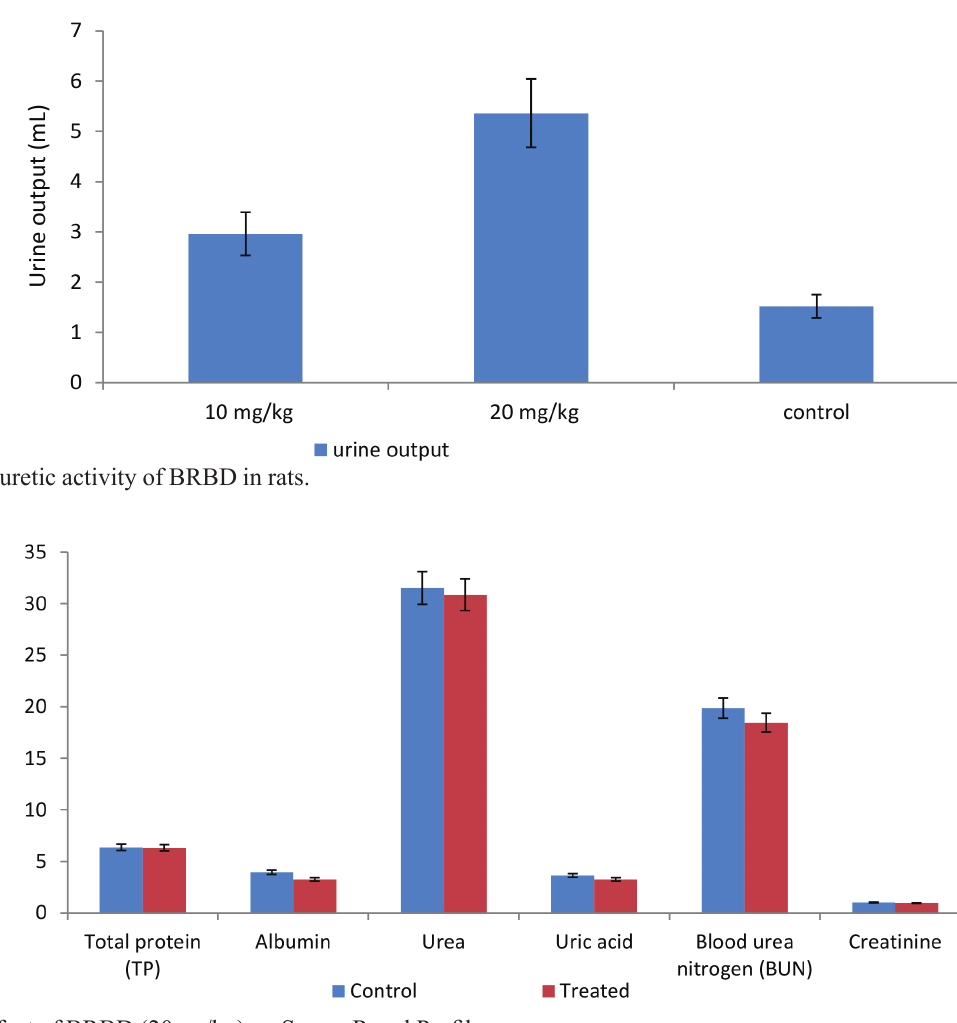
FIGURE 3 - Effect of BRBD (20mg/kg) on Serum Renal